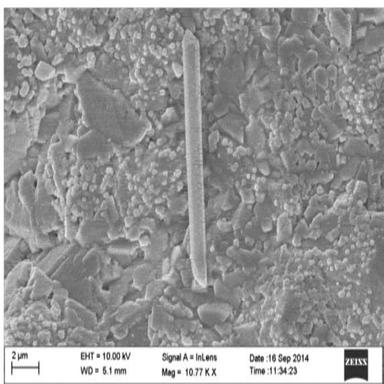
Nanostructure (scanned by SEM) ensembles of Cu grown electrochemically through single-pore of Makrofol-KG.